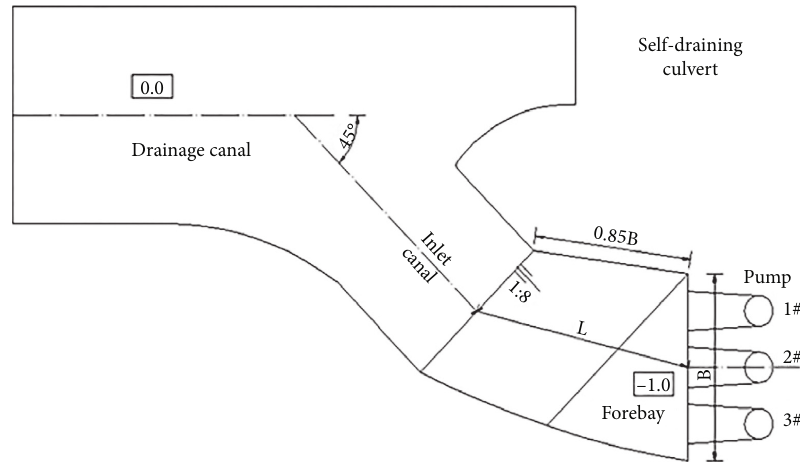
Figure 1: Layout of the intake building of the lateral intake pump station.